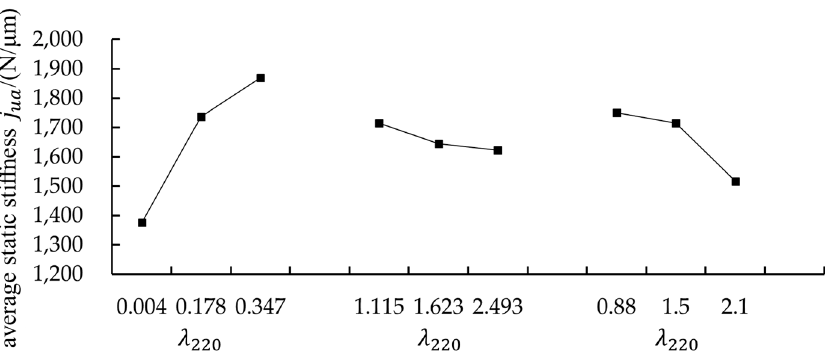
Figure 10. Trend diagram of orthogonal experiment.